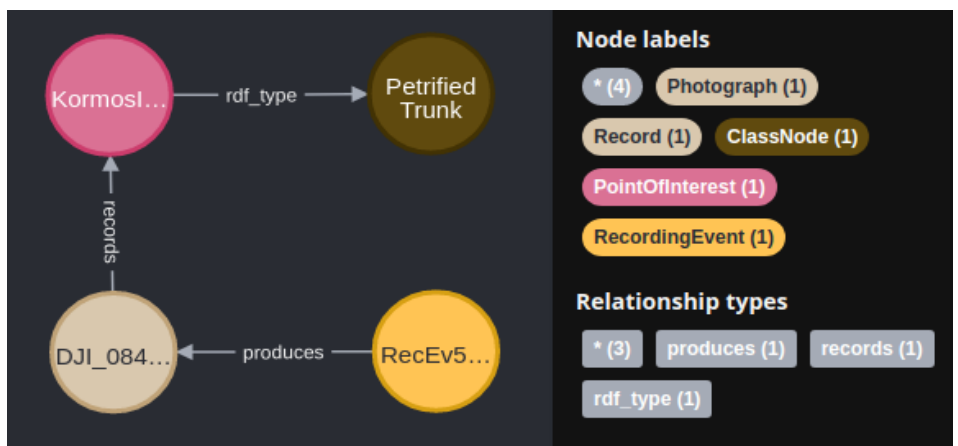
Figure 10. Part of enriched graph with POIs. The * symbol represents the number of nodes (4) and the number of relationships (3) between the nodes.